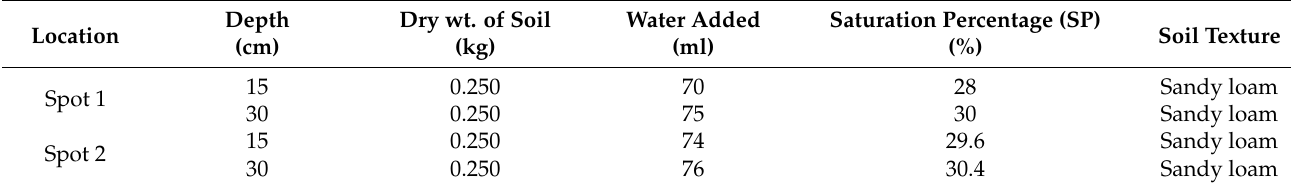
Table 1. Saturation percentage (SP) and soil texture of the experimental site.